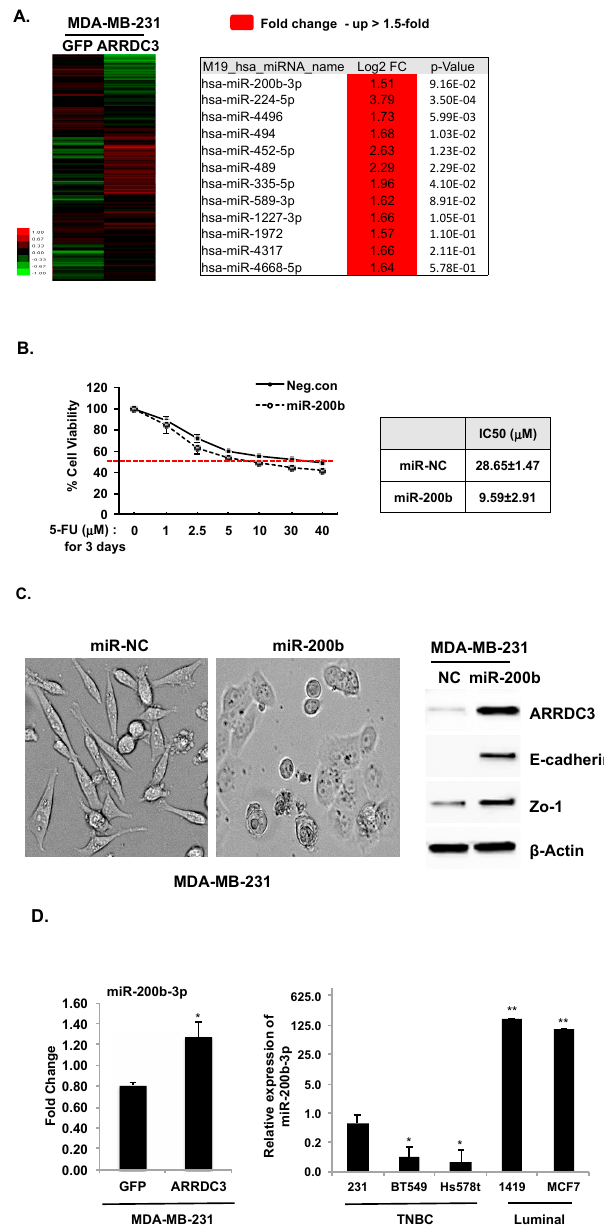
Figure 3. miR-200b-3p regulates ARRDC3 expression and forms a positive feedback loop with ARRDC3 to reverse EMT phenotypes and chemo-resistance of TNBC cells. ( A ) Clustering analysis shows miRNA profile expression between GFP (control) and ARRDC3 overexpressing MDA-MB-231cell (left panel). Signal intensity is values normalized by control gene probes and log 2 -transformed. Right table represents selected miRNAs in red color group of up-regulated miRNAs in ARRDC3-MDA-MB-231 cells ( ≥ 1.5 fold) as compared to in the GFP control 231 cells. ( B ) MDA-MB-231cell expressing either miR-200b or negative control (miR-NC) was treated with 5-FU for 72 h, and cell viability was measured by MTT assay. ( C ) MDA-MB-231cell were transfected with miR-200b or negative control. The morphological change of cells was imaged by phase contrast microscopy (left panel). The change to EMT phenotype in MDA-MB-231 cells expressing miR-200b was confirmed by Western blot analysis with the indicated antibodies (right panel). β -actin was used as loading control. ( D ) RNAs were isolated from the indicated cells and prepared as described in the Material and Method section. miR-200b expression level was quantitated by qRT-PCR. Column, mean from at least three independent experiments; bars, SD. The statistical analysis was done using Student’s t test. * , p < 0.05, ** , p < 0.01.